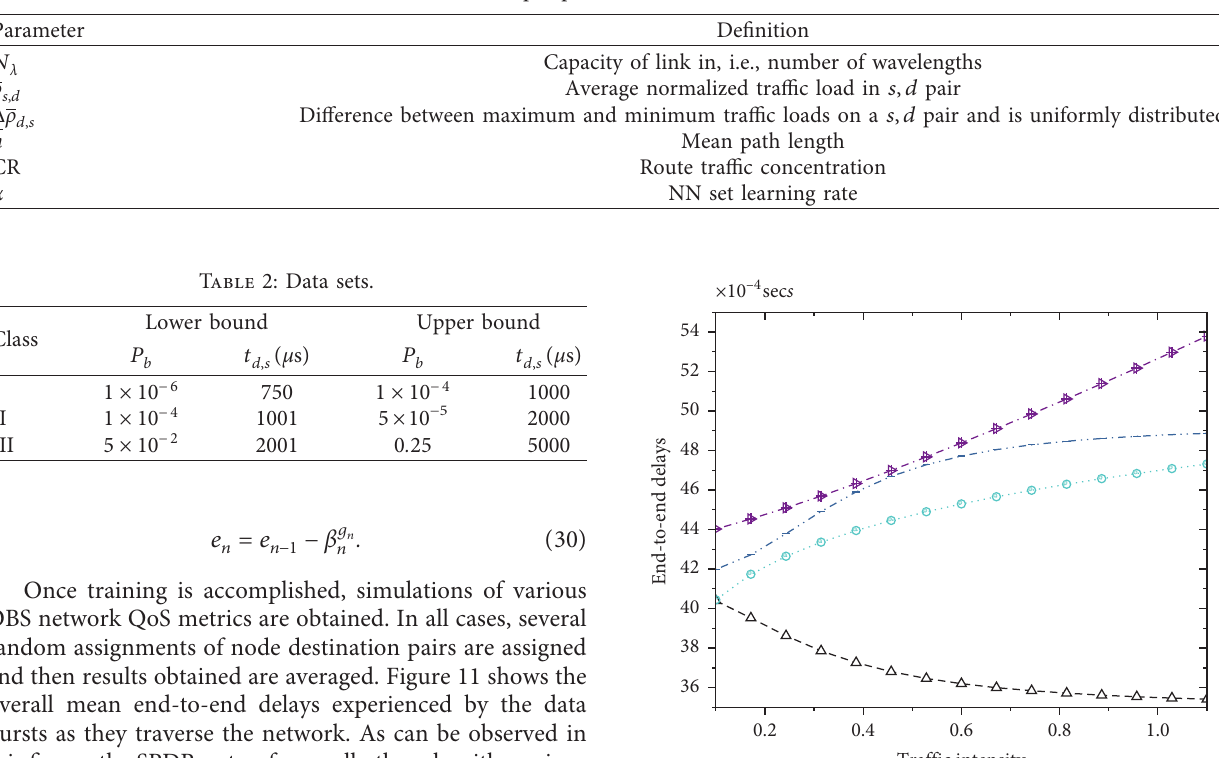
Table 1: Input parameters to the NN set.